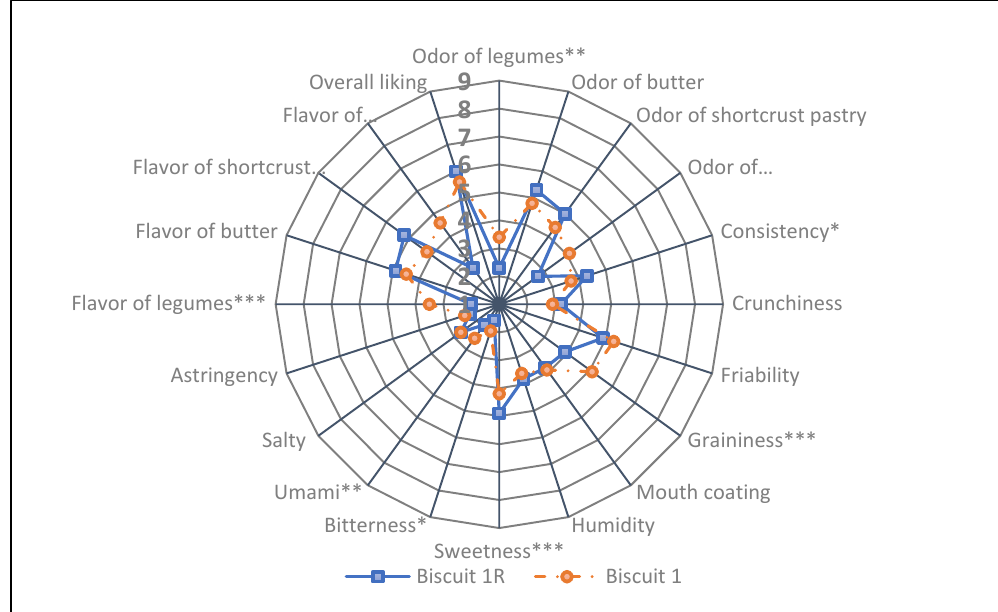
Figure 6. Sensorial profile of shortbread biscuits without (Biscuits 1R, reference) and with common bean flour (Biscuit 1). Data analyzed by ANOVA and post hoc test (Tukey’s HSD); *, **, *** indicate significant differences between the tested products at p < 0.1, p < 0.5 and p < 0.01, respectively.